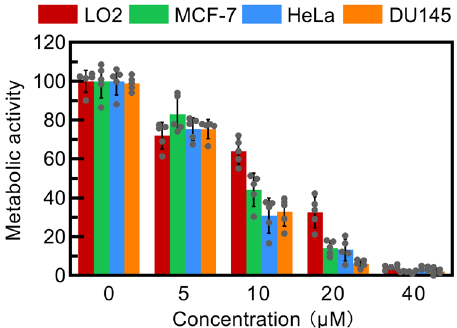
Fig. 8 The phototoxicity of PPAB-PyS NPs. Cell metabolic activity of HeLa, MCF-7, DU145, and LO2 cells stained with different concentrations of PPAB-PyS NPs under white light for 30